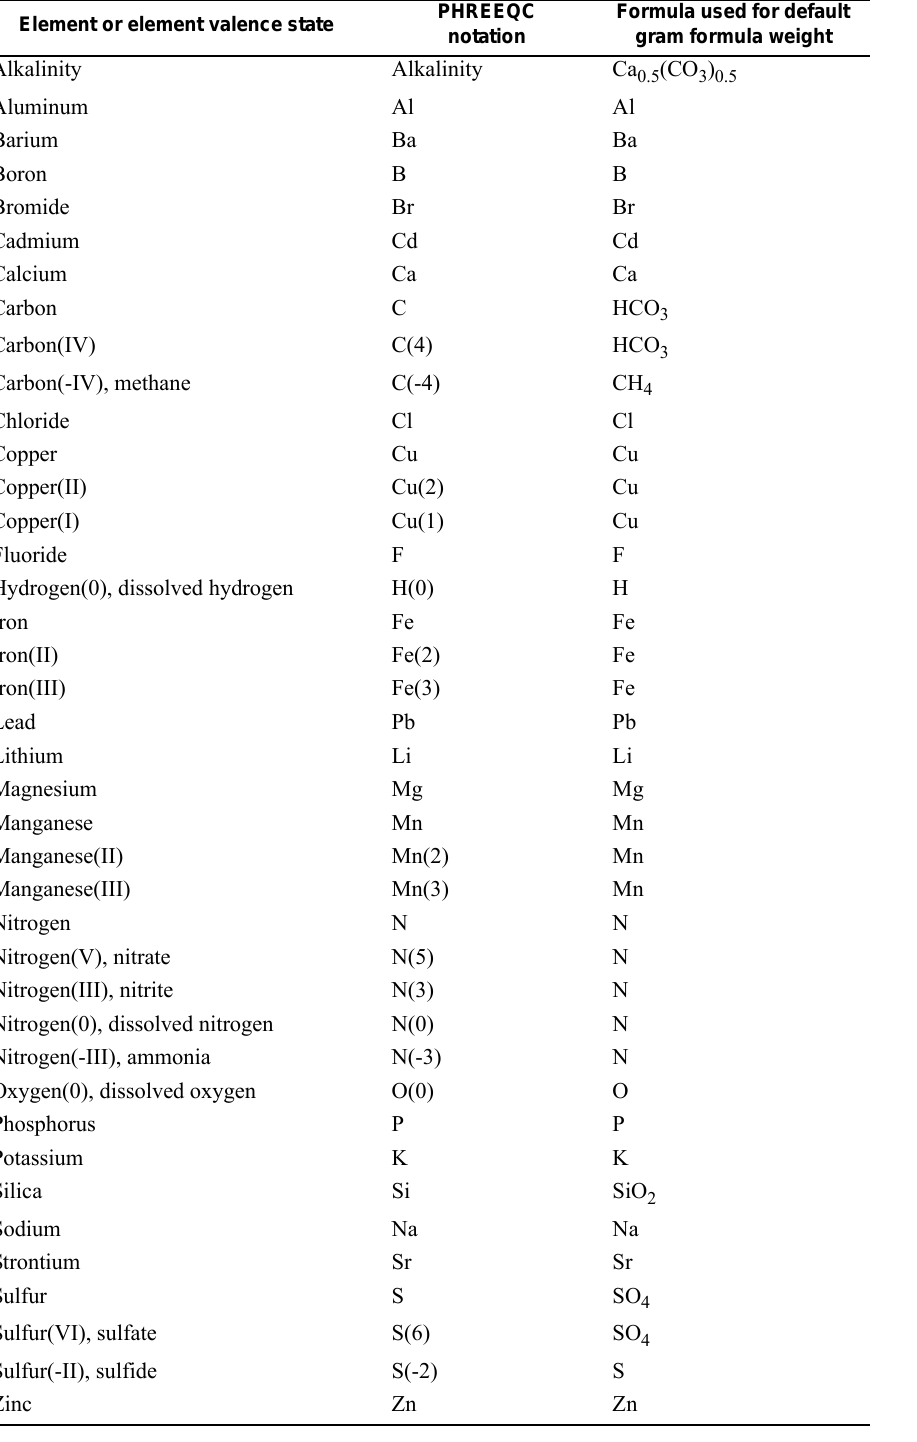
Table 3. Elements and element valence states included in default database phreeqc.dat , including PHREEQC notation and default formula for gram formula